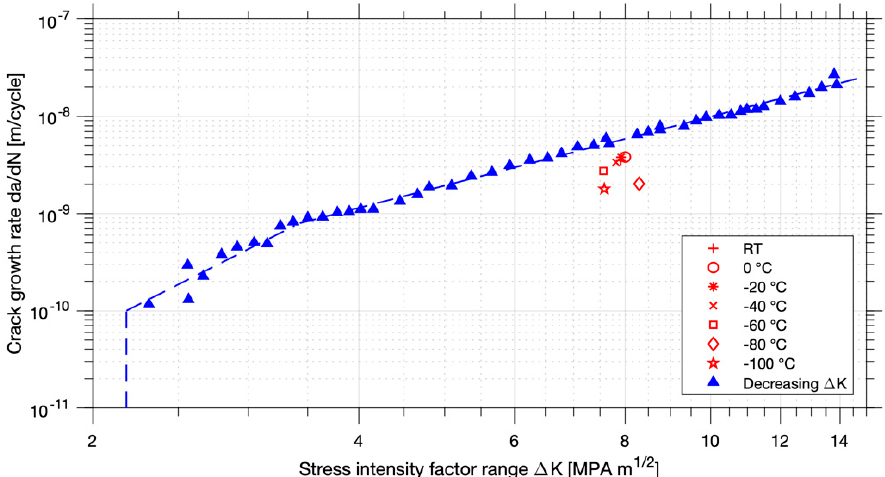
Figure 8. The results of the constant Δ K experiments of the specimen with the crack in the weld material are plotted together with the results of the decreasing Δ K experiments at room tempera-ture.